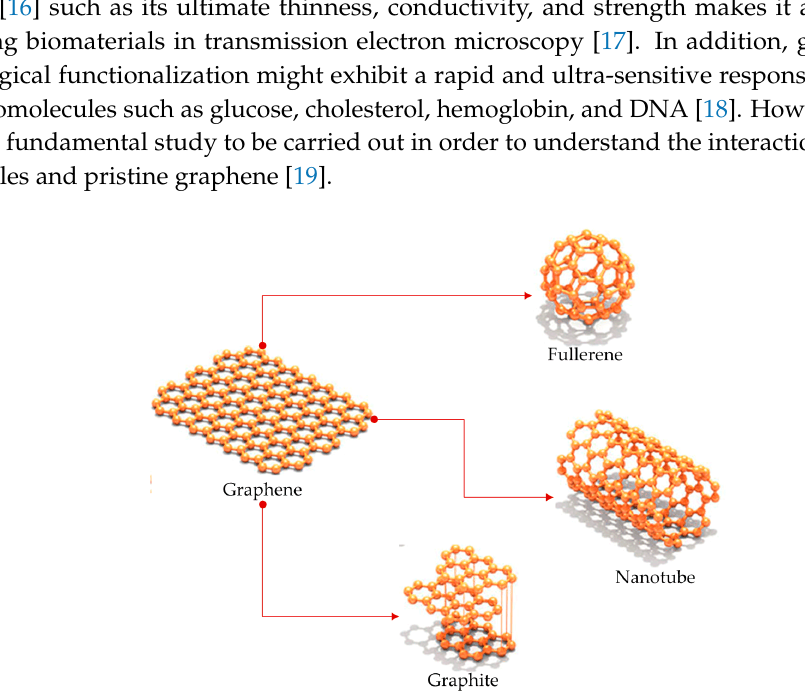
Figure 2. Excellent physical properties of pristine graphene. Figure 1. Excellent physical properties of pristine graphene.